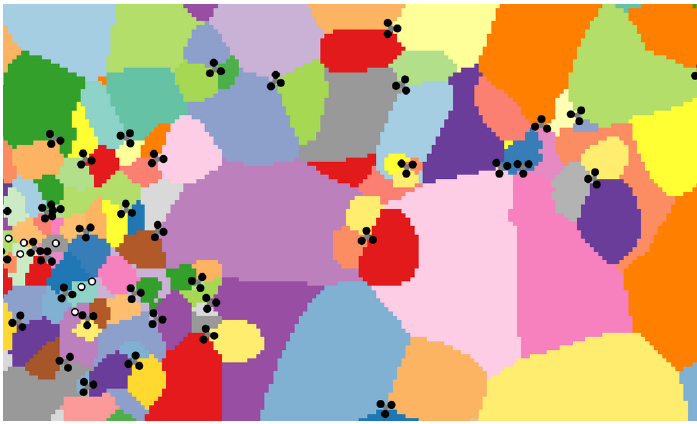
Figure 8: BSA map derived from the signal strength model using fictional cell plan